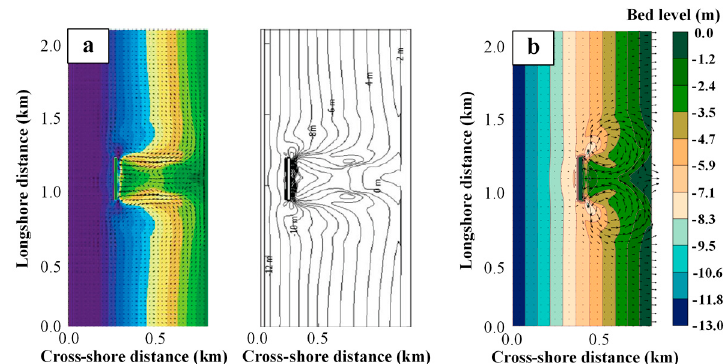
Figure A1. (a ) Salient formation at the end of simulation conducted by [38]; ( b ) replication of [38] study.